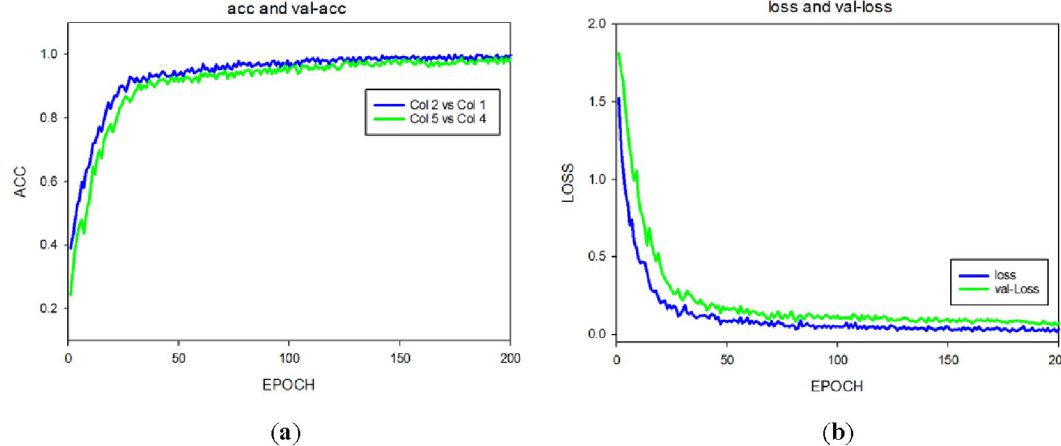
Figure 11. Model training curve results. ( a ) Classification accuracy graph, ( b ) loss graph.